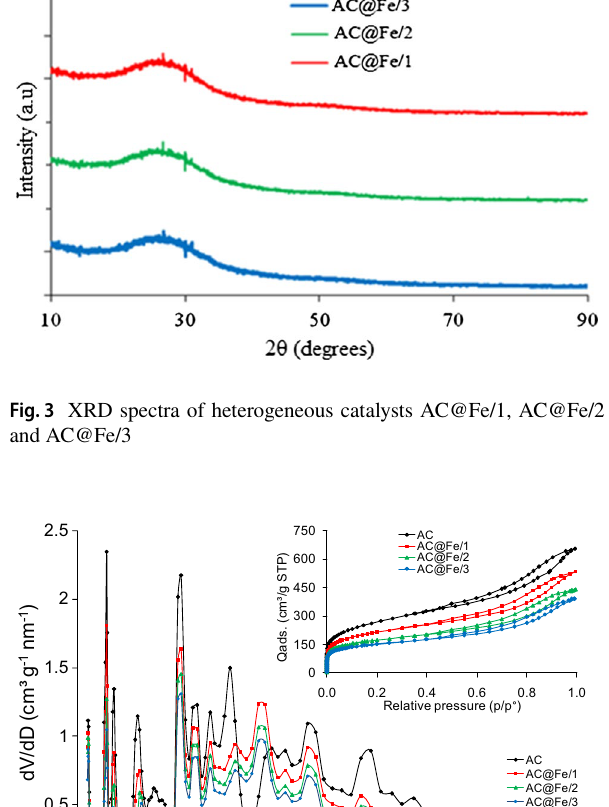
2 adsorption at